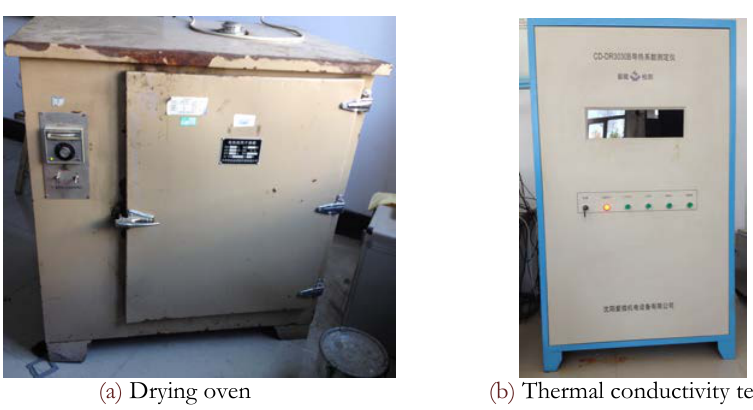
Figure 16: Main instruments for measuring the thermal conductivity